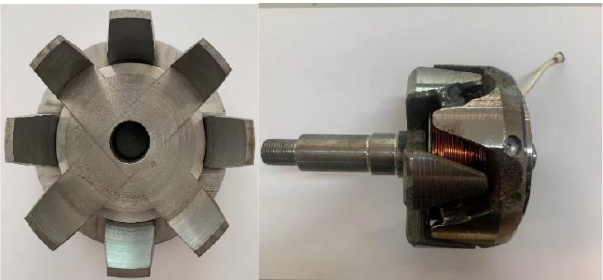
Figure 14. Reverse brushless claw-pole electrically excited prototype and conventional claw-pole electrically excited generator.